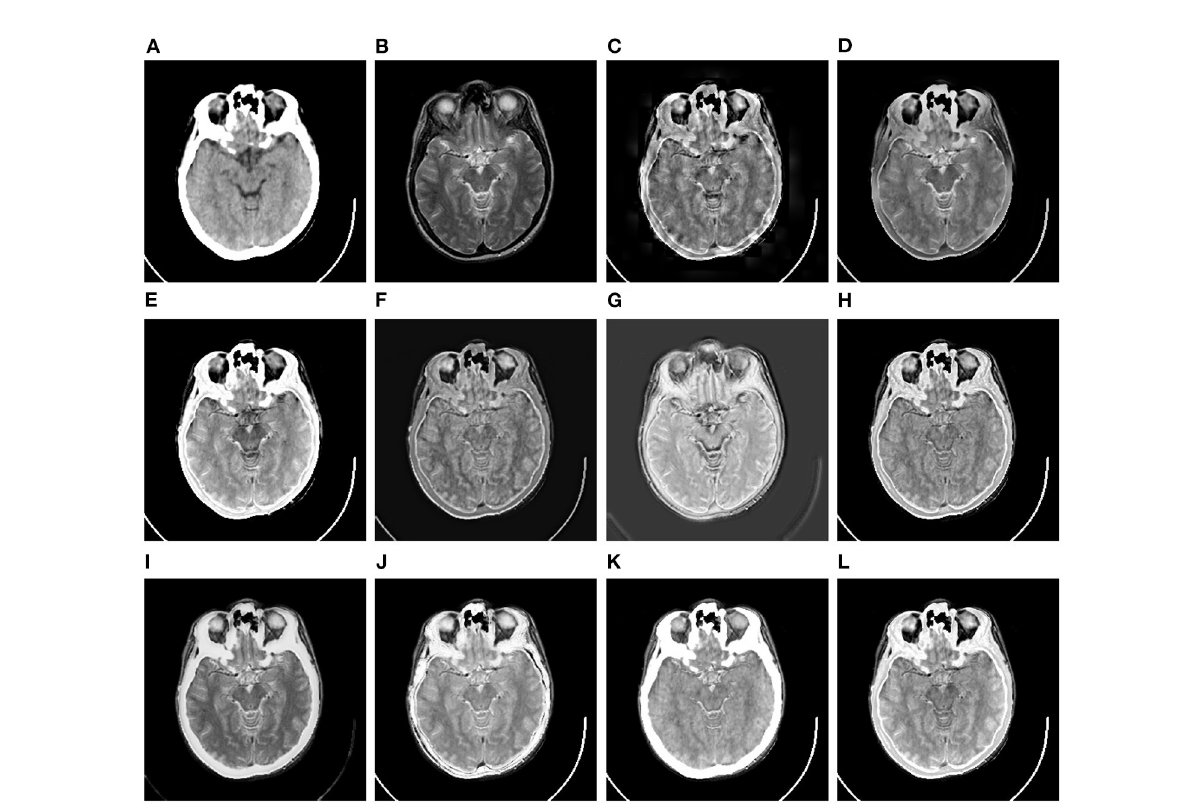
FIGURE6 Comparison example on the CT-MR image dataset. (A,B) are the original CT image and MR image, respectively. (C–L) are the fusion results of DWT, GFF, LPSR, U2Fusion, DDcGAN, IFCNN, EMFusion, DRBIF, LEGFF 0 , and our method, respectively.